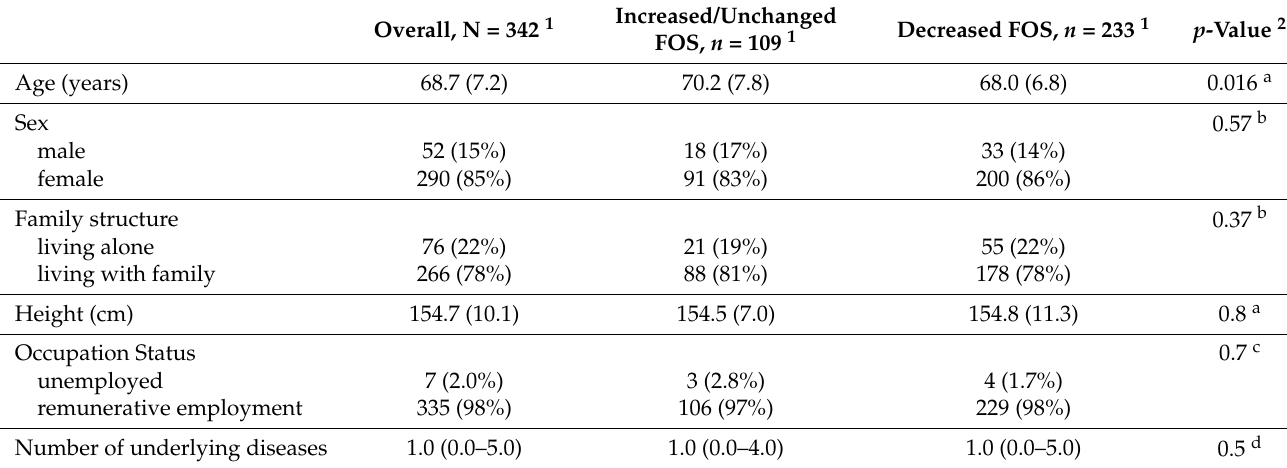
Table 1. Descriptive and bivariate statistics for